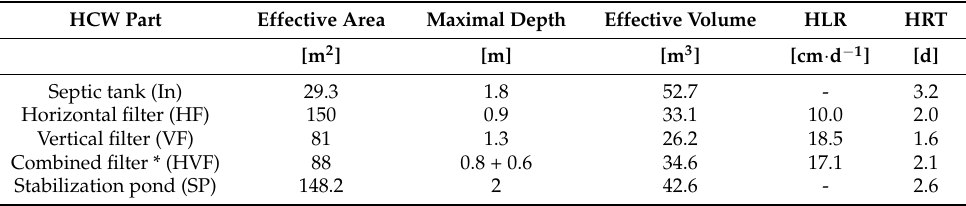
Table 1. Hybrid Constructed Wetland system parameters.